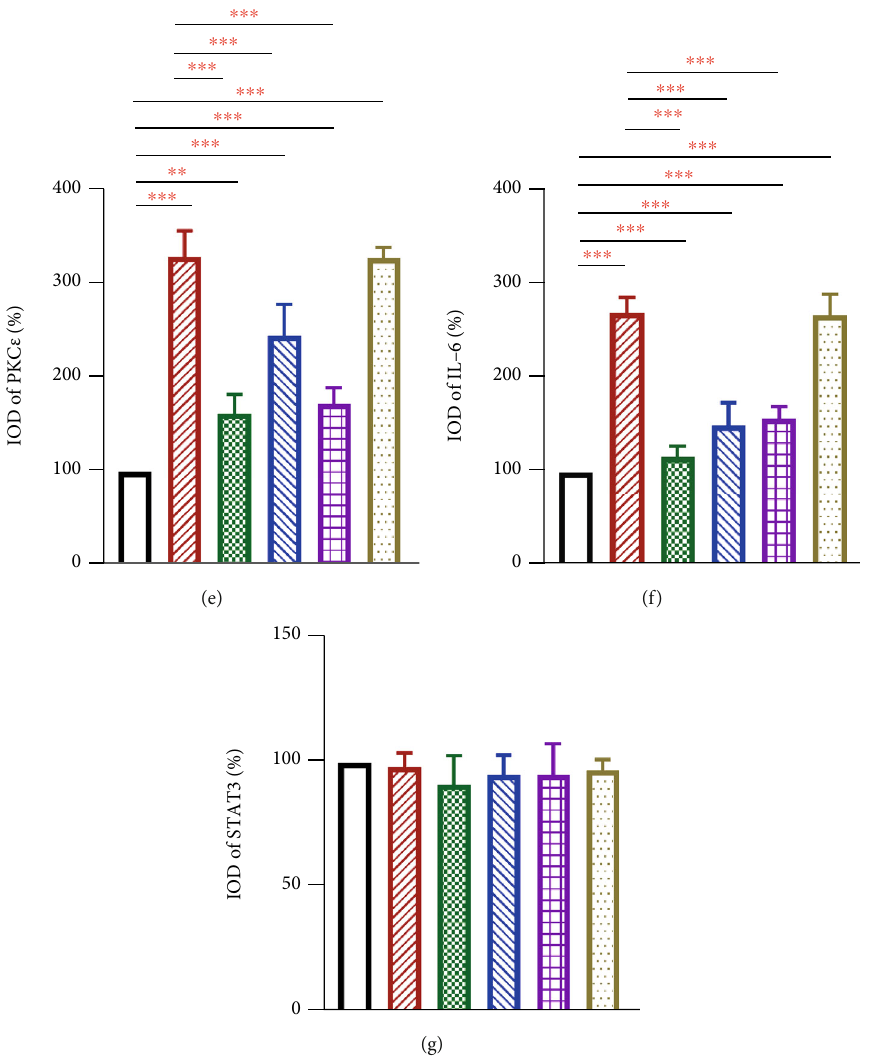
Figure 3: Western blot analysis of the proteins related to activated neurocytes during in fl ammatory pain. Examples (a) and mean values (b – g) of c-Fos, GFAP, Iba-1, PKC ε , STAT3, and IL-6 proteins in the spinal cord. Intrathecally injected T-5224 (c-Fos/AP-1 inhibitor, 500 μ g/ 50 μ L), minocycline (Mino, 100 μ g/50 μ L), and L-2-aminoadipic acid (LAA, 1mg/50 μ L) reduced c-Fos, GFAP, Iba-1, PKC ε , and